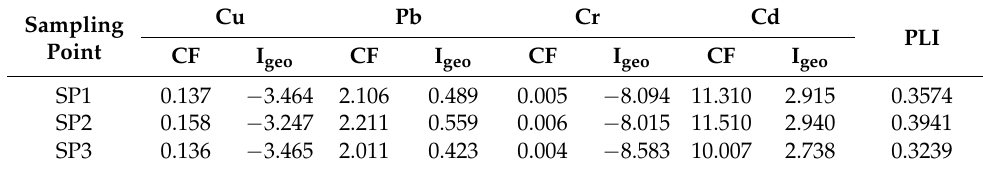
Table 5. Contamination assessment indices for sediments from Port Bell, L. Victoria,